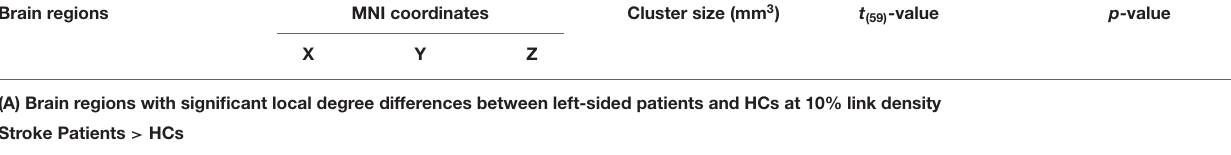
Stroke Patients > HCs